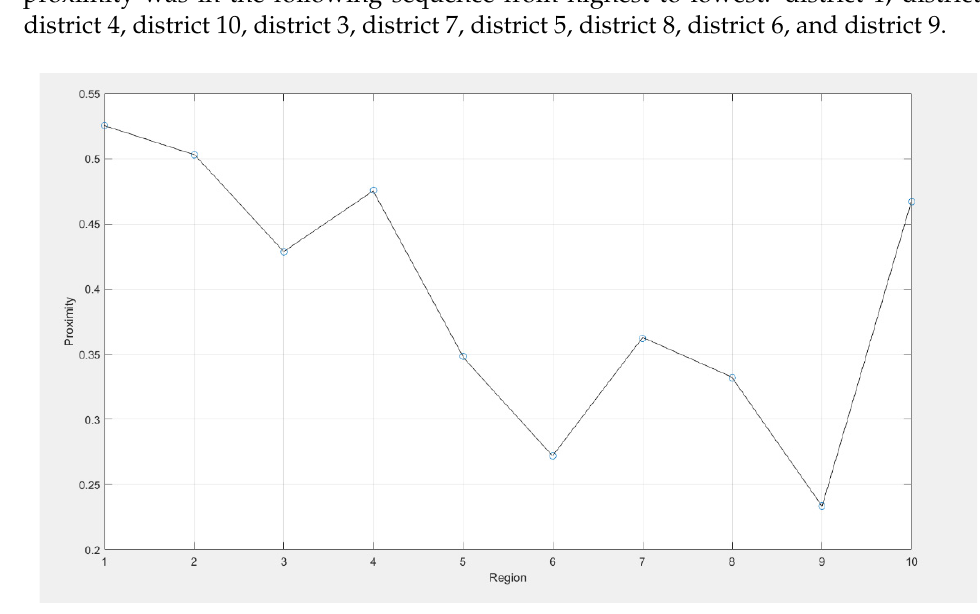
Table 7. Coordinates of candidate points.